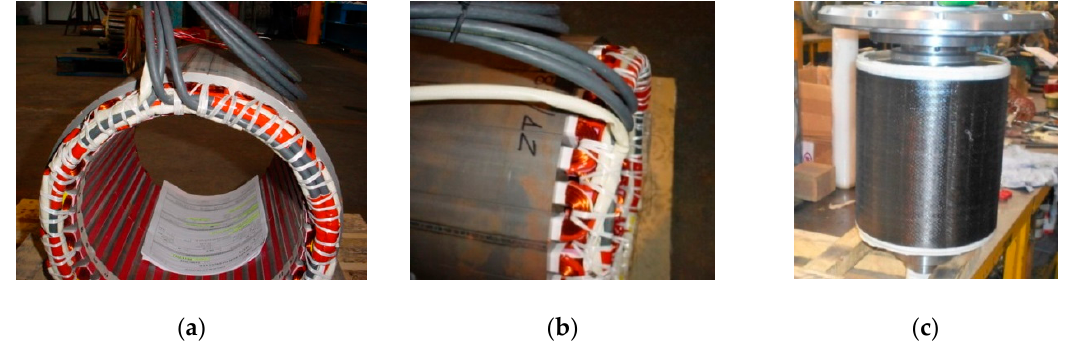
Figure 9. SPM motor: ( a ) wound stator; ( b ) stator end-windings; ( c ) carbon fiber covered rotor.